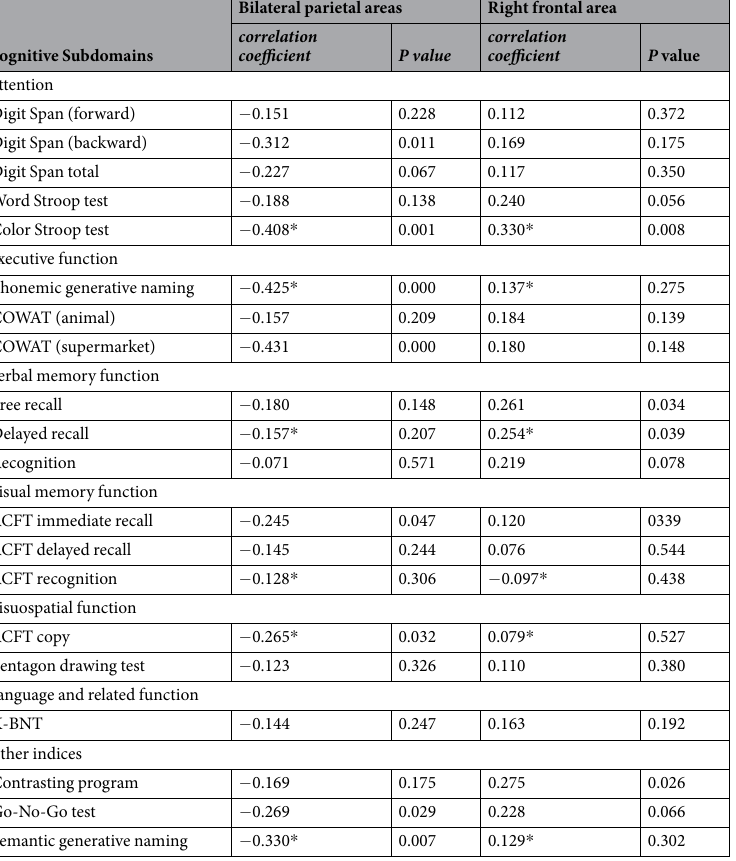
Table 3. Correlation analysis between neuropsychological data and brain regions showing altered rsFC between the collapsed PD-MCI and PD-IC groups. * Pearson’s rho ( ρ ). Unless otherwise indicated, data are Spearman’s r